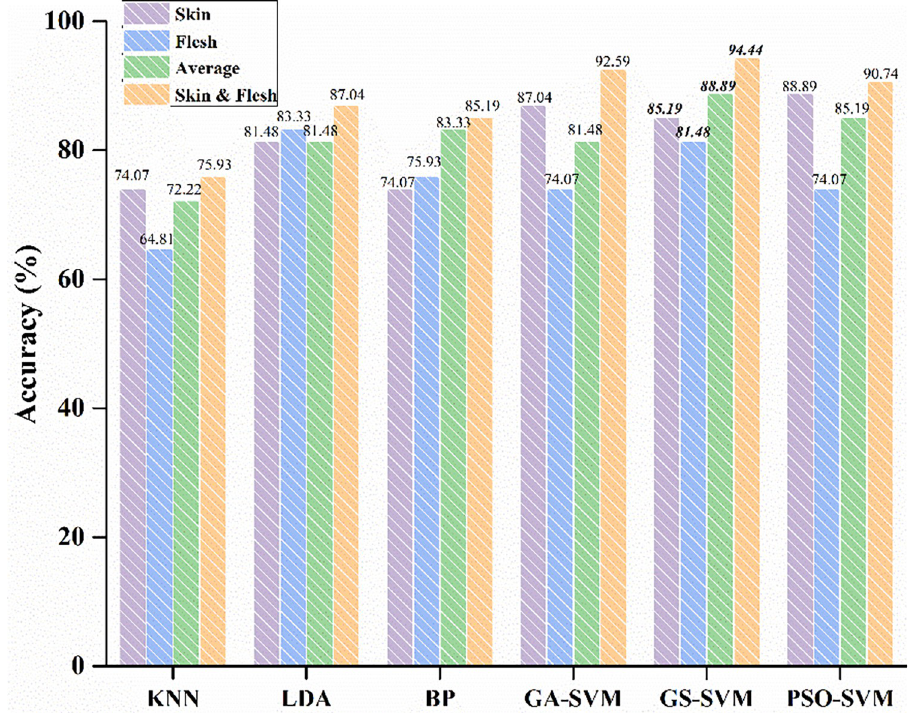
Fig 4. The average accuracy of the models for three types of